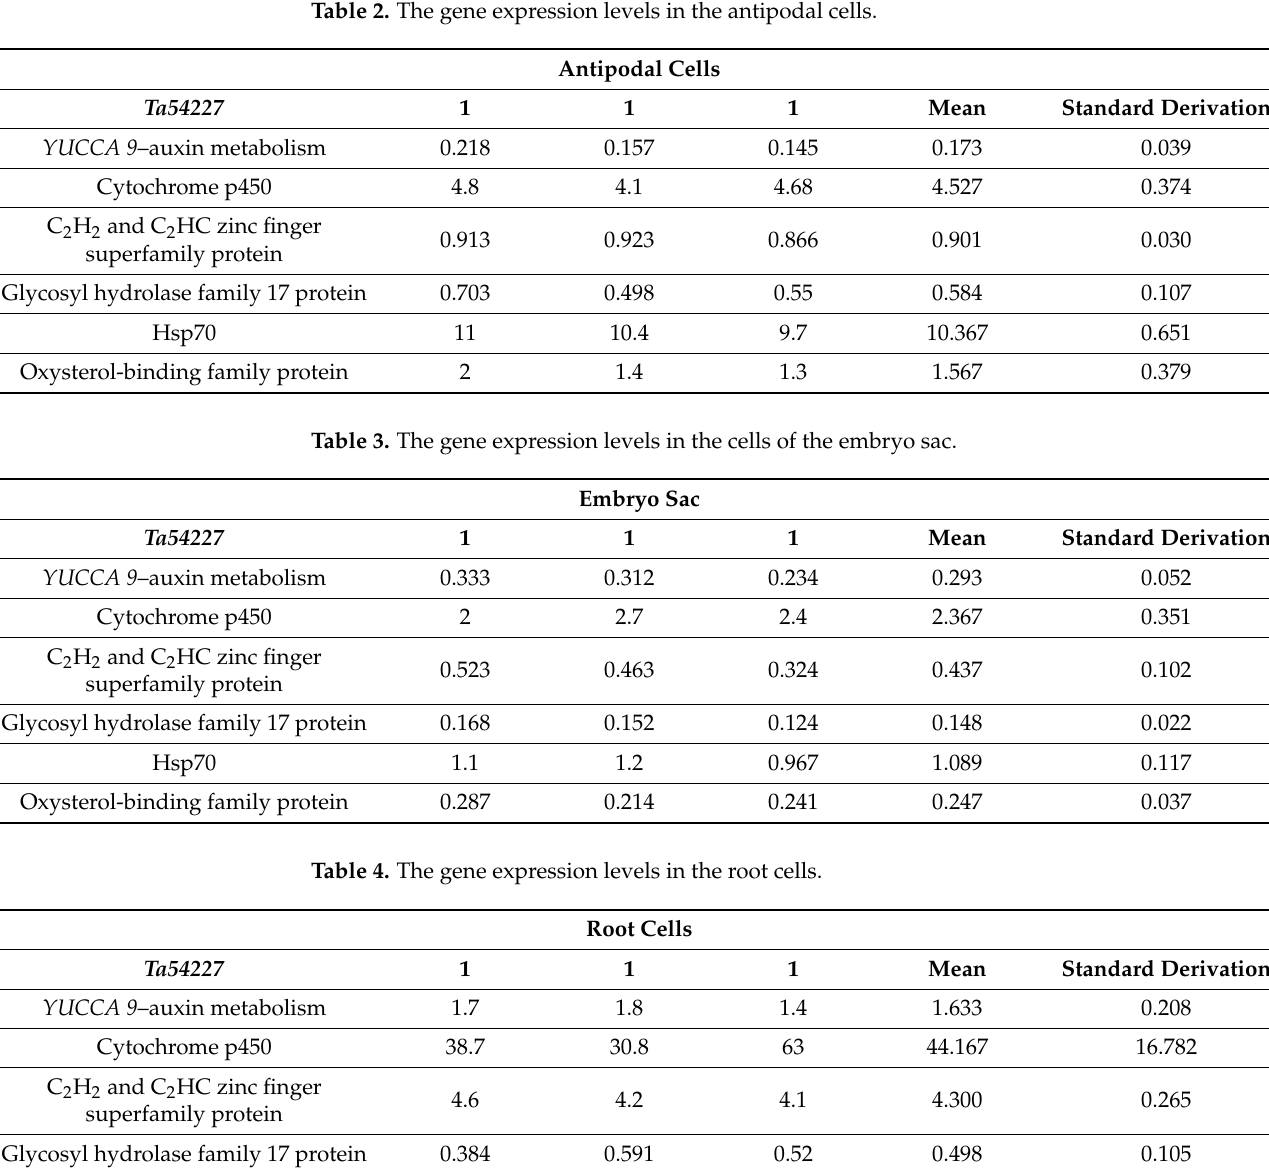
Table 2. The gene expression levels in the antipodal cells.